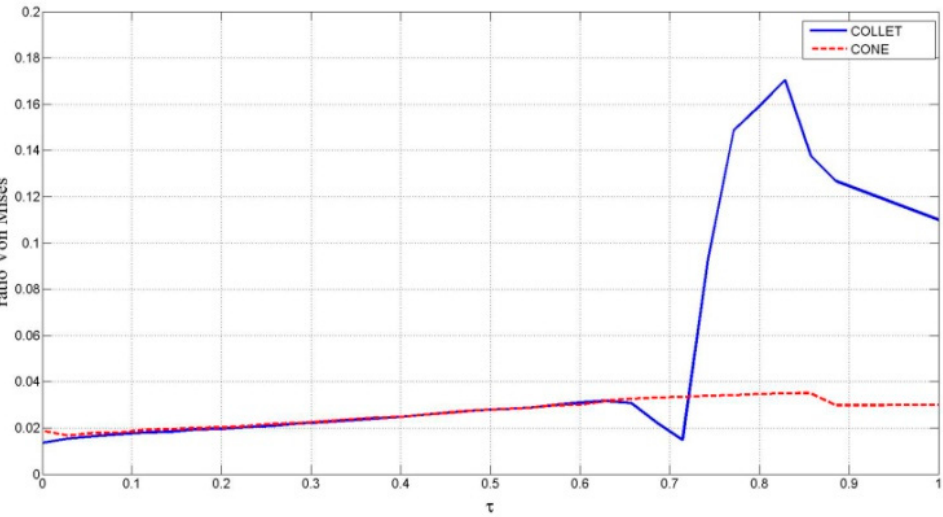
Figure 21. von Mises stress distribution ratio for cone–collet.